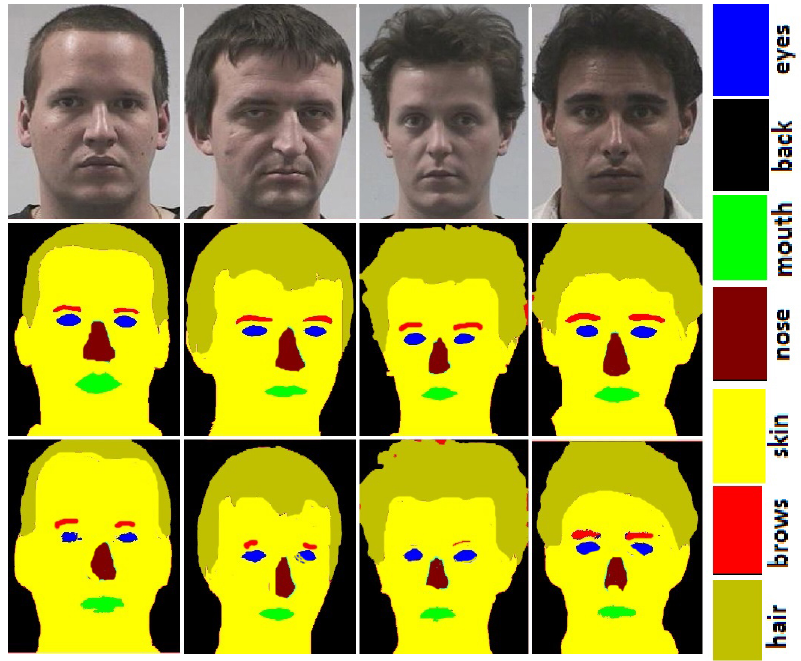
Figure 1. Face parsing results for FASSEG [29] frontal images. First row show: original images, second row: ground truth, and third row: face parsing results.